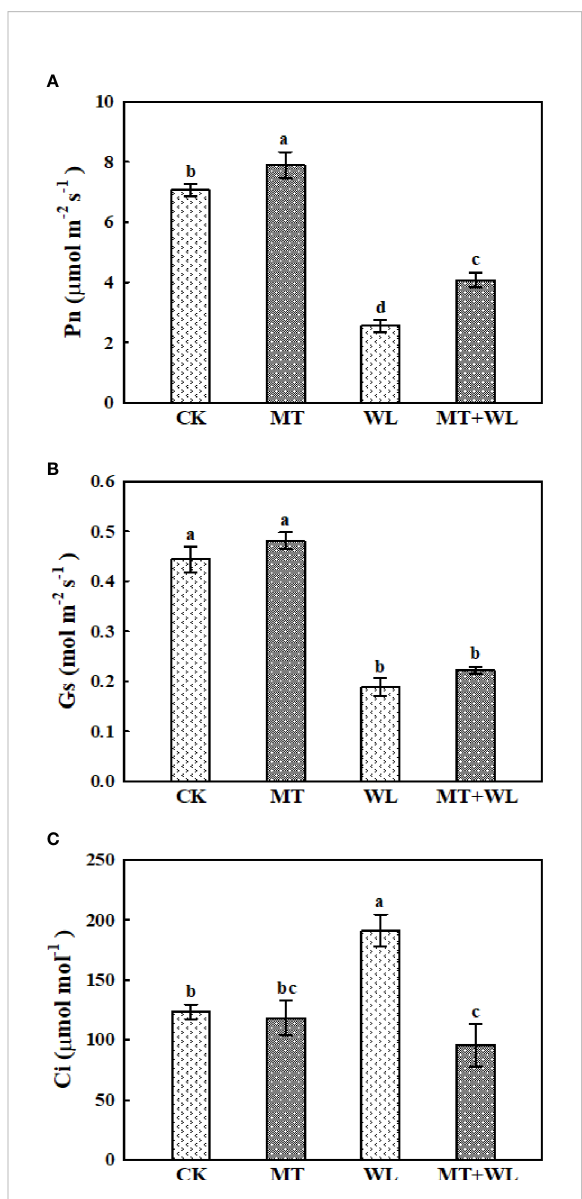
FIGURE 2 Exogenous melatonin alleviated the waterlogging damage on the photosynthetic ability of kiwifruit plants. Changes in the (A) net photosynthesis rate (Pn), (B) stomatal conductance (Gs) and (C) intercellular CO 2 concentration (Ci) were determined after 6 days of waterlogging treatment. Data are shown as the means of three replicates with SEs. Different letters indicate signi fi cant differences between treatments, according to one-way ANOVA and Tukey ’ s multiple range test (P <